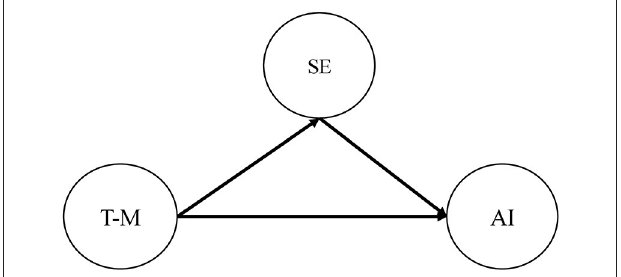
FIGURE 1 | Conceptual model. T-M, Time-management skills; SE, Academic self-efficacy; AI, Attrition Intentions (Drop-out, Transfer University, Transfer Study Field).